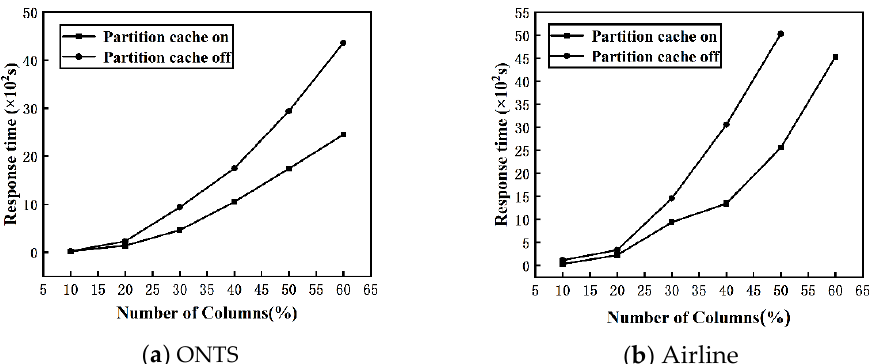
Figure 9. ( a ) Evaluation of effectiveness of partition cache (ONTS) ( b ) Evaluation of effectiveness of partition cache (Airline).